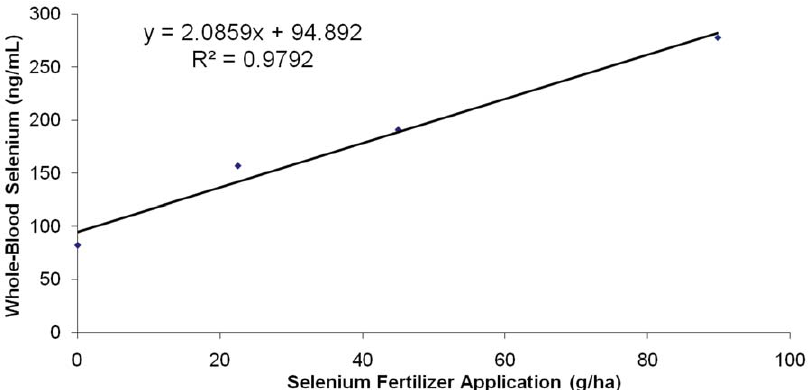
Figure 3. Relationship between amount of Se applied by fertilization (g Se/ha) and observed WB-Se content (ng/mL) in weaned beef calves consuming alfalfa hay grown in fields not fertilized with Se (0 g Se/ha), or harvested from fields fertilized with sodium- selenate at an application rate of 22.5, 45.0, or 89.9 g Se/ha for 7 wk (n=15 calves per group). The normal reference interval for whole- blood Se concentrations of beef cattle is 120 to 300